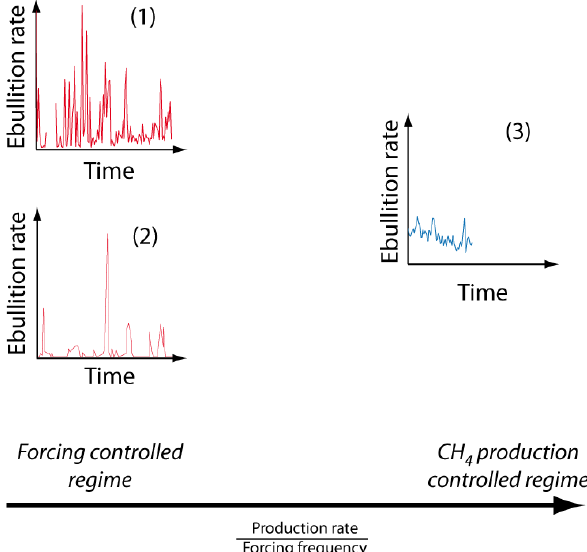
Figure 9. Conceptual framework for characterizing temporal vari- Fig. 9: Conceptual framework for characterizing temporal variability of ebullition in aquatic systems differing in 634 ability of ebullition in aquatic systems differing in the relation be- the relation between CH 4 production ratesand forcing frequency of relevant trigger mechanisms for ebullition. 635 tween CH 4 production rates and forcing frequency of relevant trig- All examples show ebullition rates (6 hour average) over a period of 4 weeks, except for (3) which refers to a 636 ger mechanisms for ebullition. All examples show ebullition rates period of 2 weeks. Example (1) shows the measured data from this study (Saar, ABT-1, January 2013), example 637 (6-hour average) over a period of 4 weeks, except for (3), which (2) shows measurements from the Upper Mystic Lake (25 m site, October) taken from Varadharajan et al. 638 refers to a period of 2 weeks. Example (1) shows the measured (2012) and example (3) showsmeasured data from the River Main, Germany, (Krotzenburg Dam, September 639 data from this study (Saar, ABT-1, January 2013), example (2) 2012). 640 shows measurements from the Upper Mystic Lake (25m site, Octo- ber) taken from Varadharajan et al. (2012) and example (3) shows measured data from the River Main, Germany (Krotzenburg Dam, September